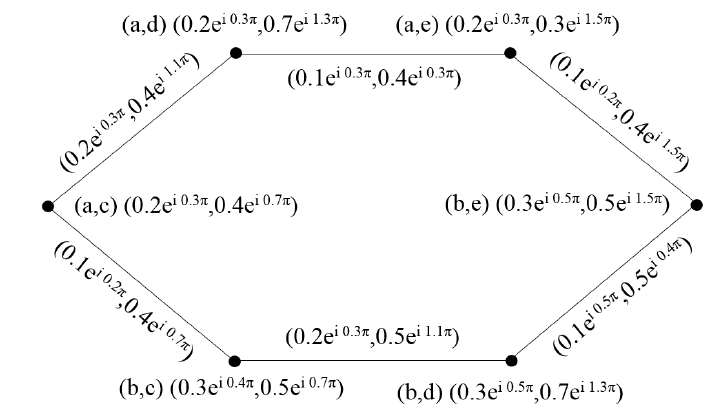
Figure 4. Complex intuitionistic fuzzy graph of G 1 × G 2